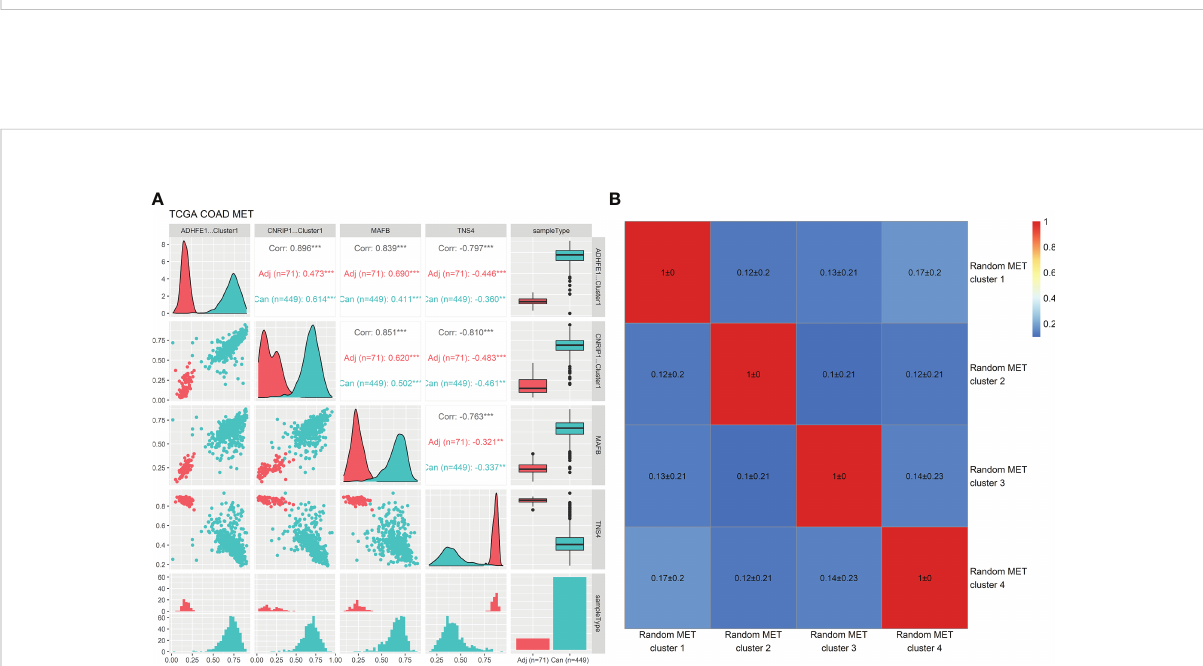
FIGURE 6 Correlation analysis of the methylation levels of the four iRFE MDGs and randomly selected MDGs in the TCGA-COAD dataset. (A) Correlation plots and distribution of the methylation levels of the four iRFE MDGs. (B) Averaged correlation coef fi cients of methylation levels of randomly selected MDGs (100 repeats). iRFE, iterative recursive feature elimination; MDGs, methylation-driven genes. **P < 0.01; ***P <